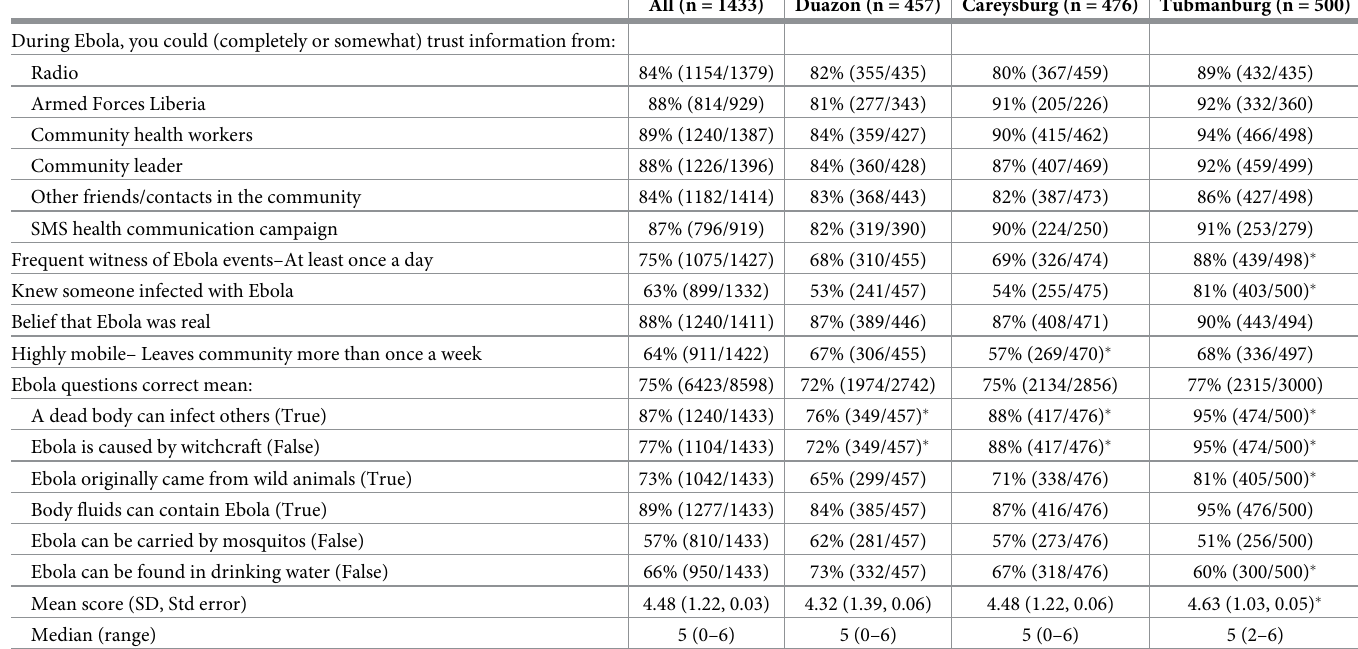
Table 2. Ebola trust, experiences, and knowledge in aggregate (n = 1433) and in each of three study locations: Duazon (peri-urban, high Ebola exposure), Careysburg (rural, low incidence), and Tubmanburg (urban, high incidence). Non-response for Ebola knowledge questions were assumed incorrect. � indicates value for this site is statistically significantly different ( p < 0.05) than the other two sites according to a Fisher’s Exact Test used pairwise for proportions and a t-test used pairwise for numeric values. All (n = 1433) During Ebola, you could (completely or somewhat) trust information from: